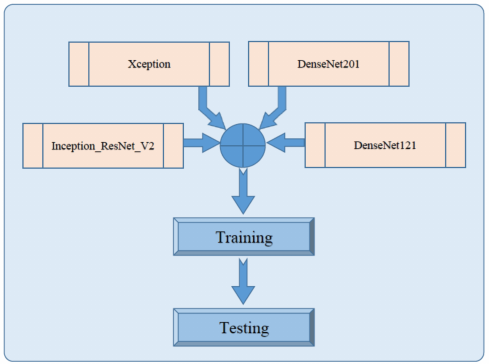
Figure 7. Block diagram of proposed stacked ensemble model.